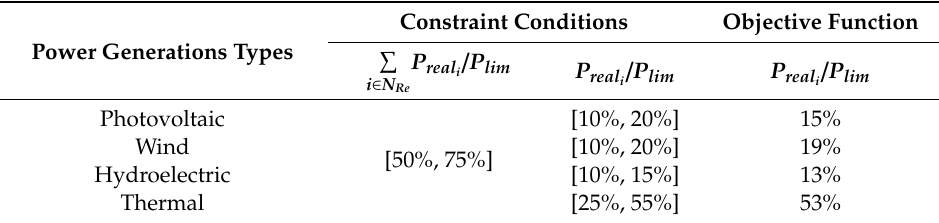
Table 2. The objective function and constraint conditions based on the quality of service (QoS) index of energy